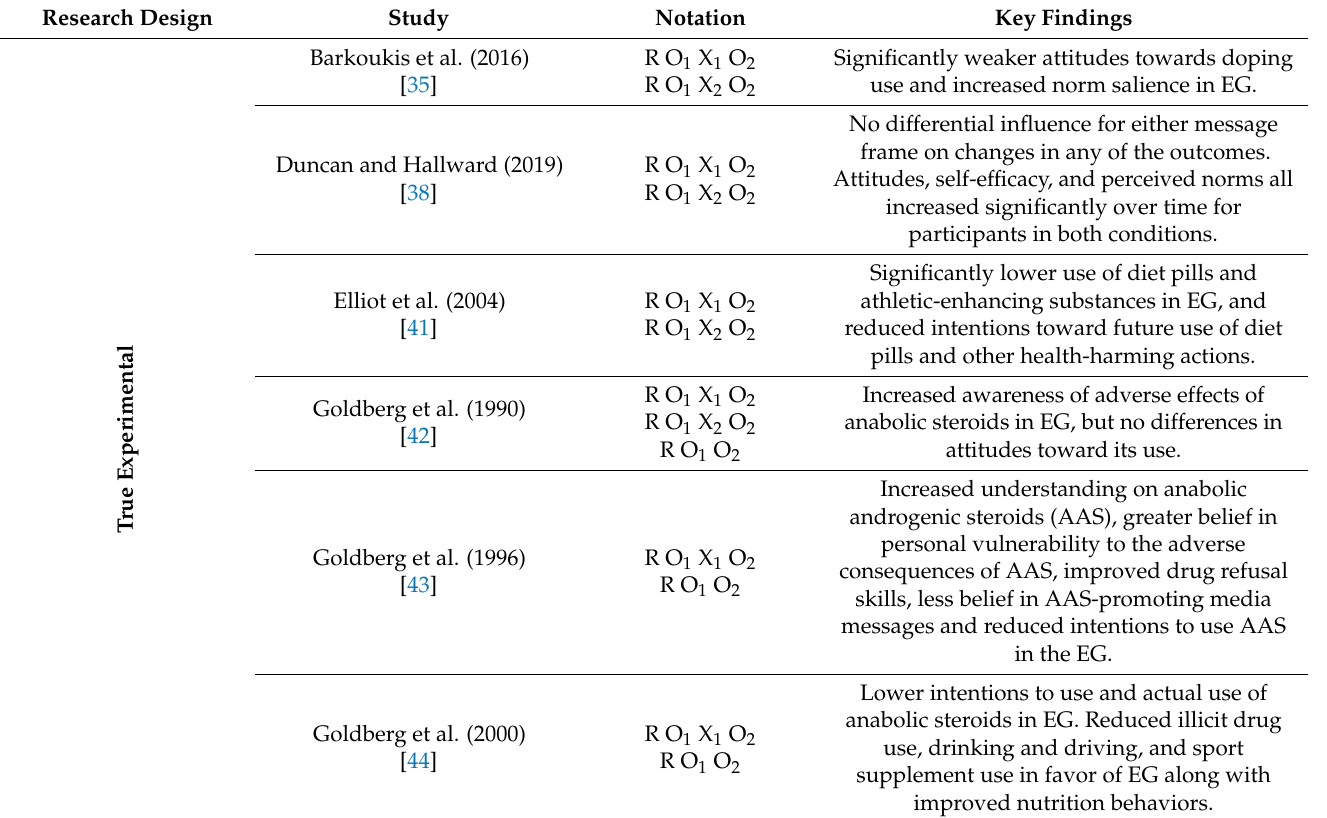
Table 2. Research Designs and Key